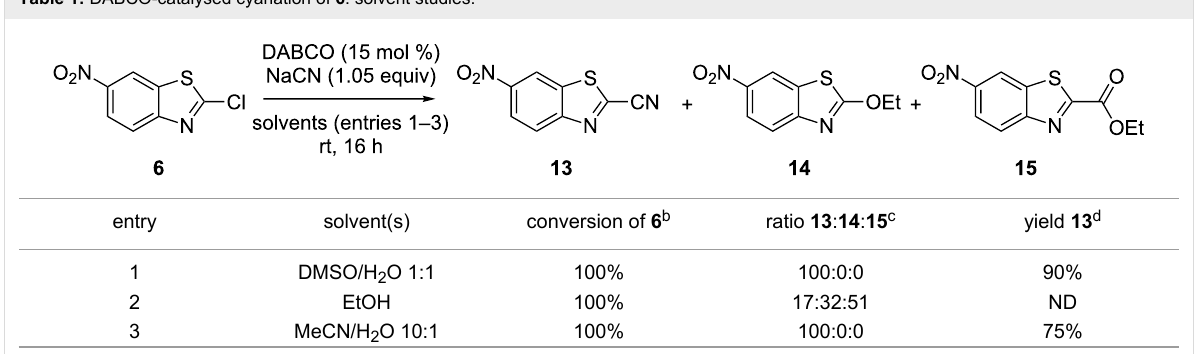
Table 1: DABCO-catalysed cyanation of 6 : solvent studies.